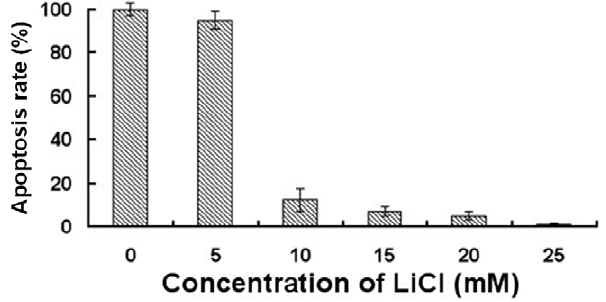
Figure 7. Inhibitory effect of LiCl on cell apoptosis analyzed by immunofluorescence. The cell apoptosis was analyzed after virus- infected ST cells were treated with LiCl at different concentrations. Mock-treated cells were used as control. The cells were stained with FITC-conjugated Annexin V and the fluorescence signals were detected under fluorescence microscope. The calculated apoptosis rate is provided.